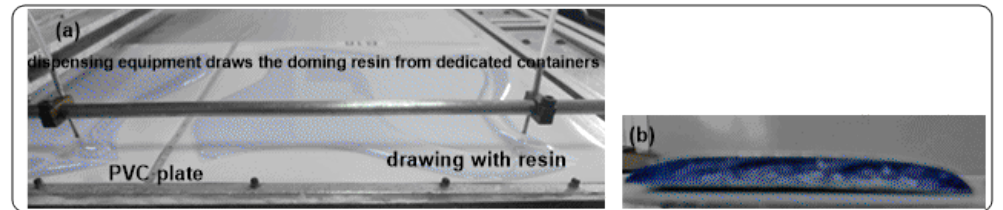
Figure 1. Example of Mosaico Digitale ® (Pepe & CO, Gravina, BA, Italy)) tile prepared with polyurethane ( PU_MD ) deriving from fossil Domes polyol: ( a ) Deposition of Tile on PVC; ( b ) section of piece of tile: The “mosaico digitale” technology uses three components: (i) the resin, from which the dome or lens is formed, (ii) the dispensing equipment, that receives the resin from dedicated containers